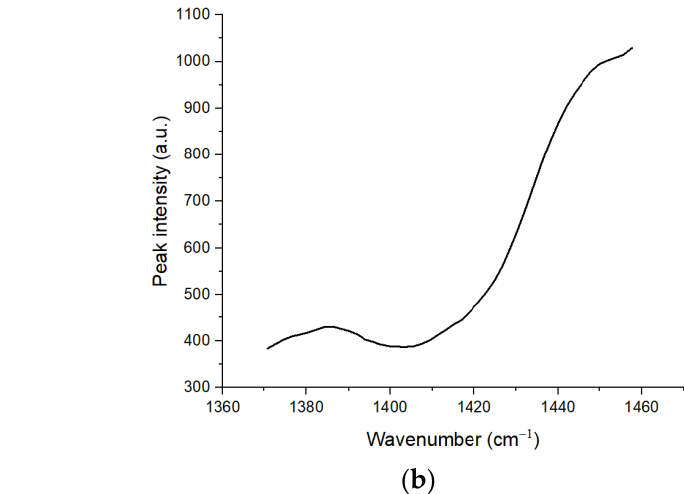
Figure 2. ( a ) Segmented Area 1 (920 to 1040 cm −1 ); ( b ) Segmented Area 2 (1370 to 1460 cm −1 ).